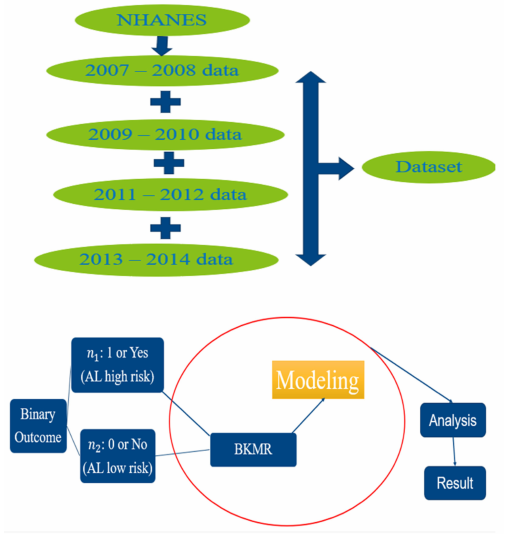
Figure 1. Flow chart for